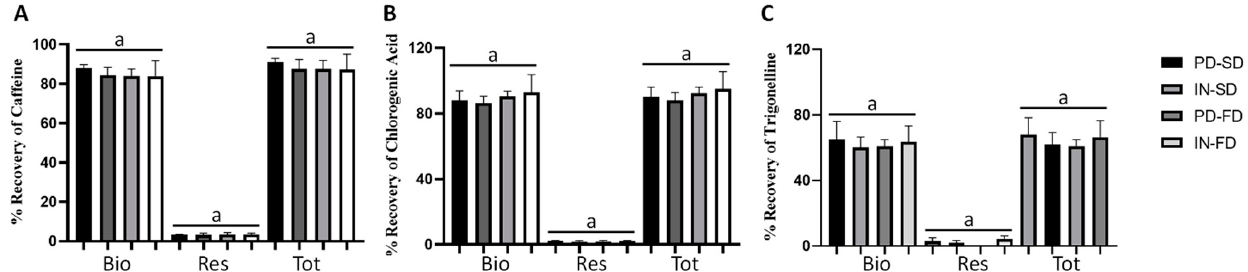
Figure 3. Percentage recovery of main phenolic compounds presents in beverages incorporated with encapsulated extracts of green coffee after in vitro digestion. ( A ) Caffeine; ( B ) chlorogenic acid; ( C ) trigonelline. Bio: bioaccessible fraction; Res: residual fraction; Tot: % Total Recovery. Data presented as mean ± standard deviation of three replicates. Different lower-case letters in each sample represent statistical difference according to the Tukey test ( p ≤ 0.05). PD-SD: beverage added from the extract encapsulated with polydextrose by spray-dryer; IN-SD: beverage added from the extract encapsulated with inulin by spray-dryer; PD-FD: beverage added from the extract encapsulated with polydextrose by freeze-drying; IN-FD: beverage added from the extract encapsulated with inulin by freeze-drying.